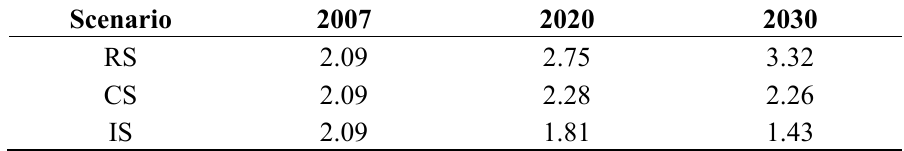
Table 6. Per capita carbon emissions under the three scenarios (units: t-C/person).